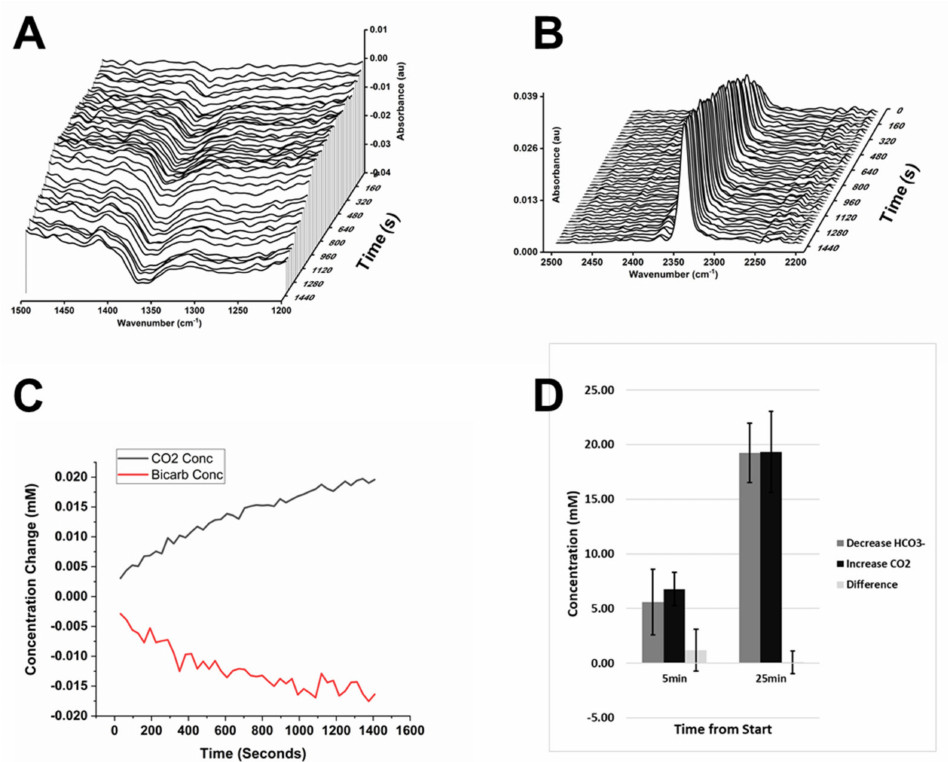
Figure 2. Comparison of formation of CO 2(aq) and consumption of HCO 3 − (aq) in single cell measurements. ( A ). Decrease of the HCO 3 − (aq) absorption band at 1361 cm − 1 . ( B ). Increase of the CO 2(aq) absorption band at 2343 cm − 1 . ( C ). Changes in the concentration of CO 2(aq) and of HCO 3 − (aq) corresponding to the absorption changes in A and B. ( D ). Comparison of CO 2(aq) formation and HCO 3- (aq) consumption in individual adherent HEK- cFXN cells with normal expression of frataxin and the difference between CO 2(aq) formation and HCO 3 − (aq) consumption calculated for each cell. Means from three cells (error bars show ± σ